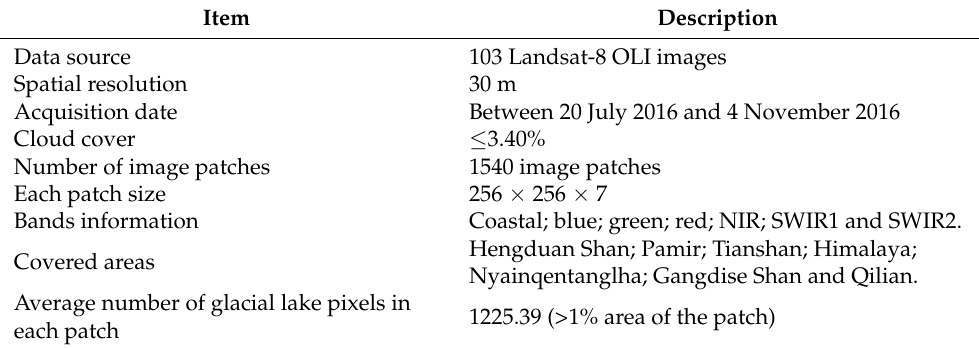
Table 1. Details of our